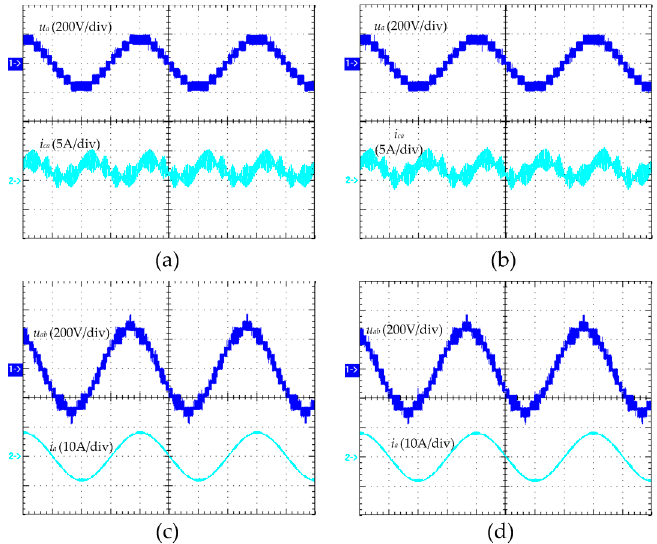
Figure 13. Experimental waveforms of DCPDPWM method and PSCPWM method with output voltage harmonics minimization scheme: ( a ) phase voltage and circulating current of DCPDPWM; ( b ) phase voltage and circulating current of PSCPWM; ( c ) line-to-line voltage and phase current of DCPDPWM; ( d ) line-to-line voltage and phase current of PSCPWM.